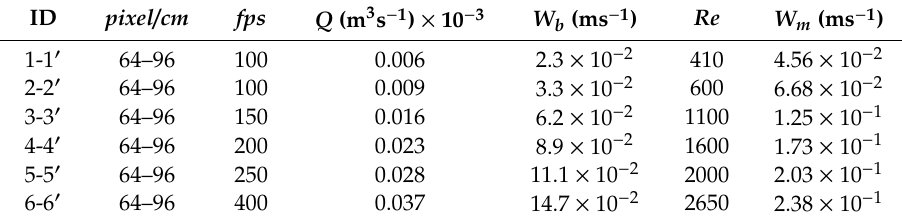
Table 1. Experimental parameters in the performed experiments: spatial resolution pixel / cm , image acquisition frame rate fps , flow rate Q , bulk velocity W b , Reynolds number Re , maximum longitudinal velocity in the healthy aorta W m